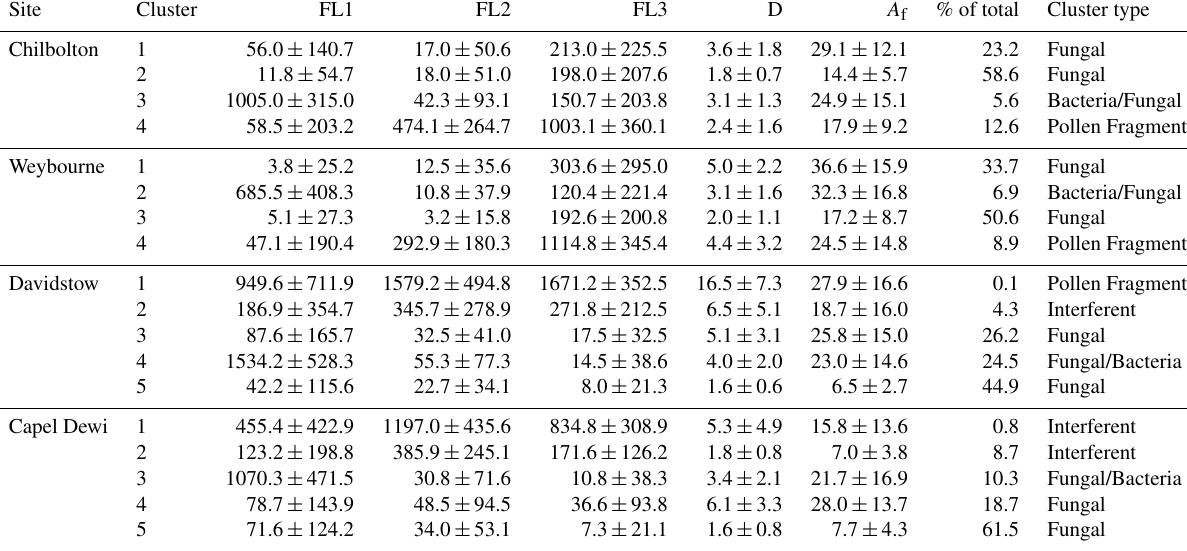
Table 2. HAC Ward linkage analysis at each site displaying the average fluorescent intensities per channel (FL1, FL2, and FL3); the average optical diameter, D (µm); the average asymmetry factor ( A f ), and the percentage contribution to the total fluorescent particle count, and inferred cluster type following the HAC